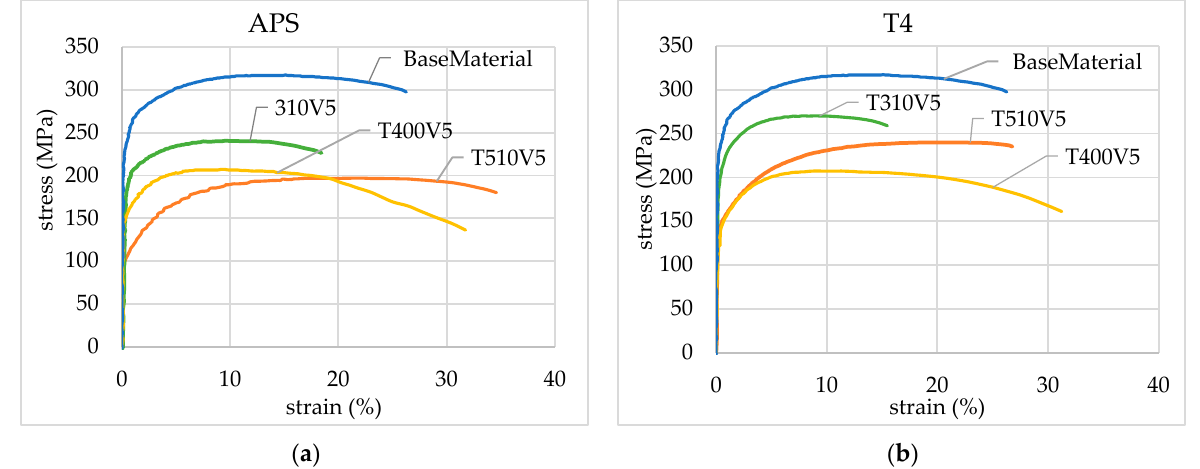
Figure 27. ( a ) Stress–strain curves of base material and those obtained in APS state for laser thermal cycles at a treatment speed equal to 5 mm/s; ( b ) Stress–strain curves of base material and those obtained in T4 state for laser thermal cycles at a treatment speed equal to 5 mm/s.